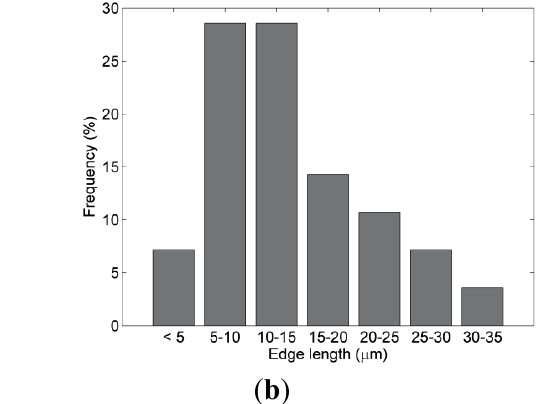
Figure 7. 3D geometric model of ( a ) the whole LN and ( b ) the 20 µm slice showing the FRC network, B cell follicles and the medulla.